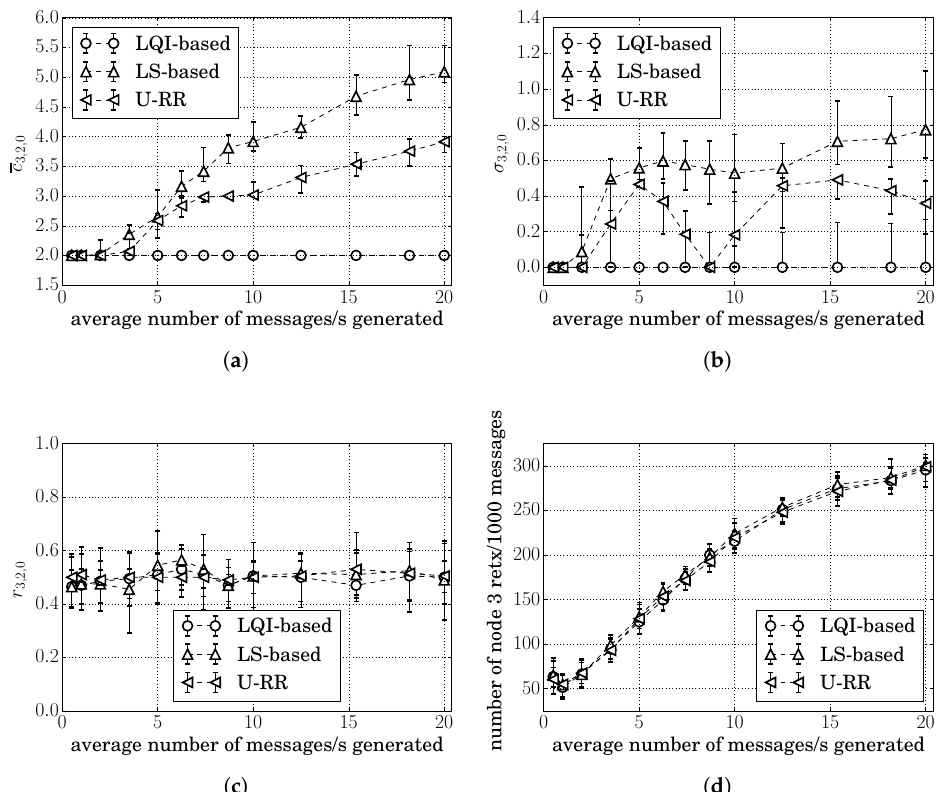
Figure 4. The median and the 15th to 85th percentiles of ( a ): the cumulative route cost of route 3,2,0 ( c 3,2,0 ), ( b ): the standard deviation of the estimated costs measured at node 3 for the route 3,2,0 ( σ 3,2,0 ), ( c ): the ratio of times that route 3,2,0 was chosen ( r 3,2,0 ), and ( d ): the number of times that node 3 had to retransmit for every 1000 messages for the symmetric scenario